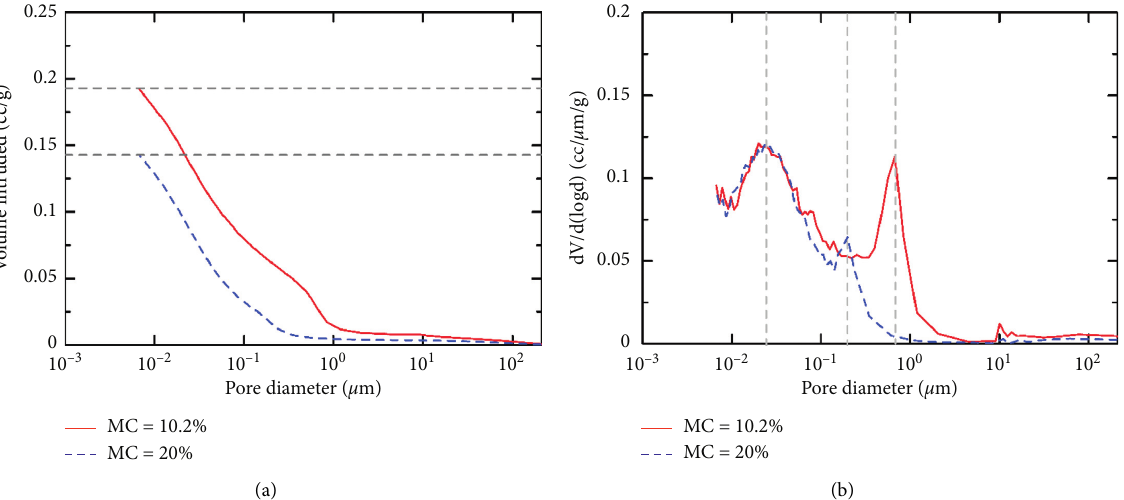
Figure 15: PSD of granular bentonite with the same initial void ratio and different moisture contents. (a) Cumulative pore volume and (b) PSD